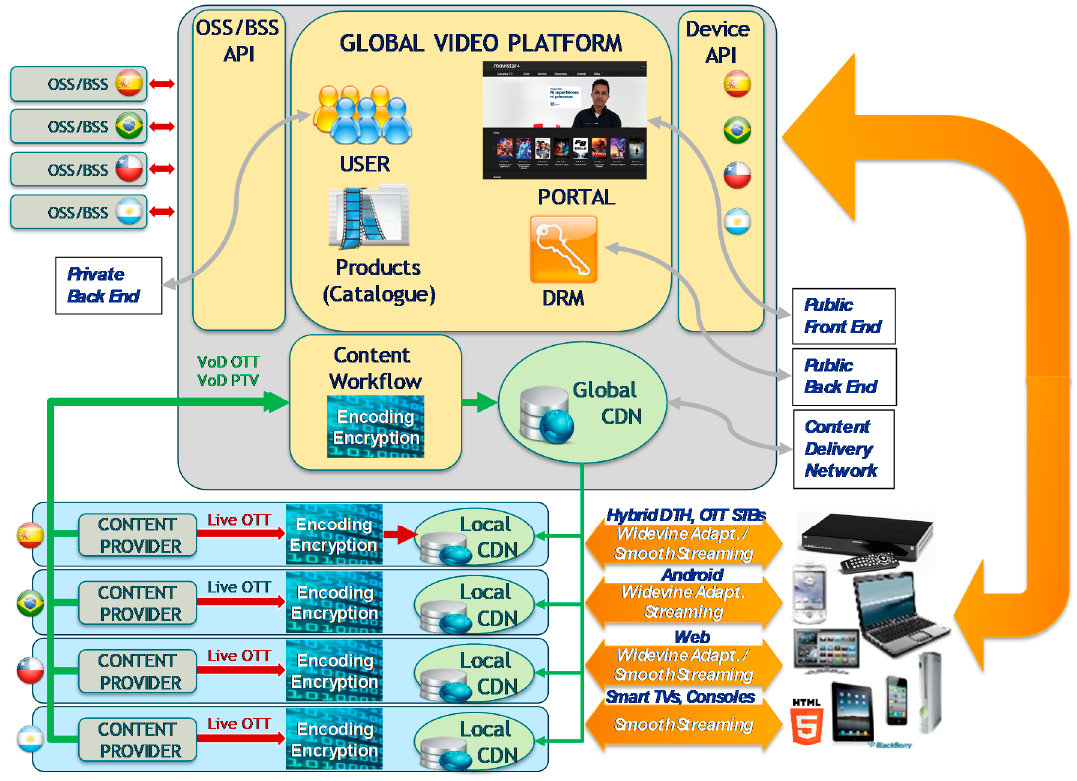
Figure 3. Video service environment.